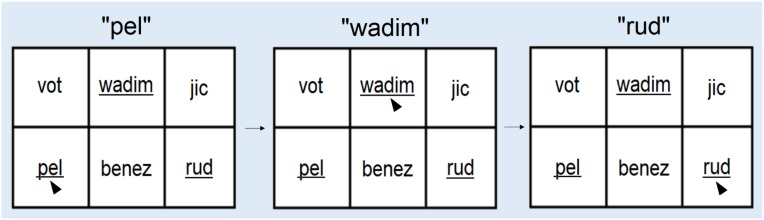
Example trial showing the grid of word stimuli displayed on the computer screen. The cursors (added for emphasis) point to the target string in each third of the trial (pel, wadim, rud, underlined for emphasis). The other three words are foils (vot benez jic).